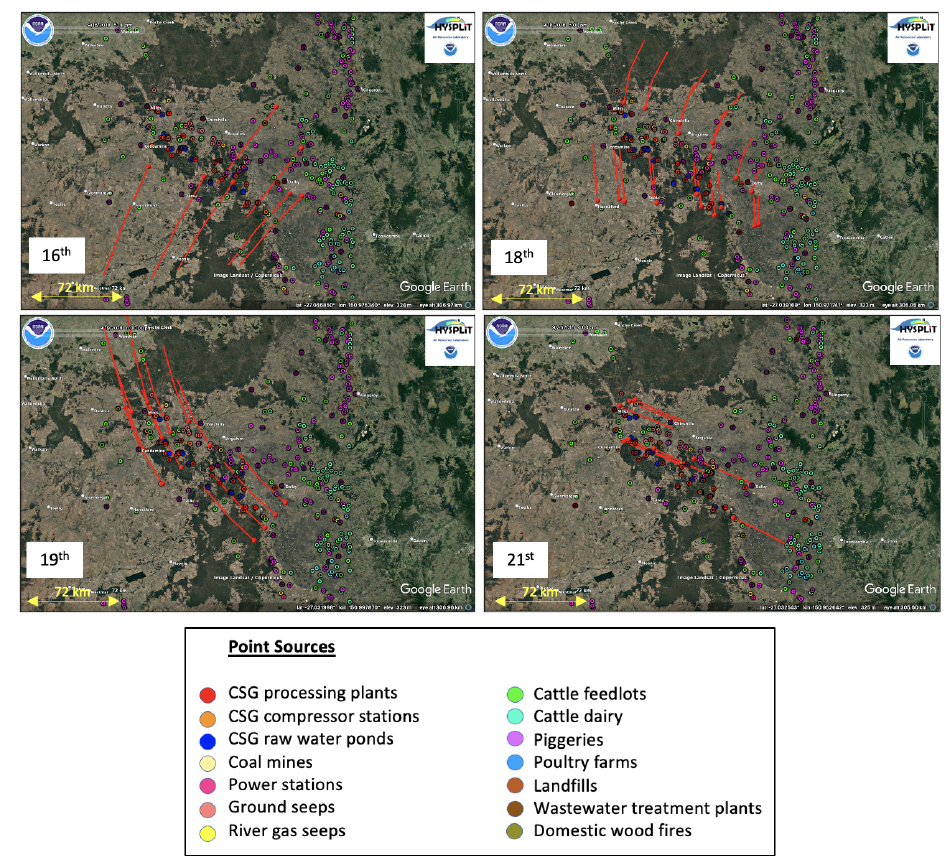
Figure A1. Two-hour HYSPLIT back-trajectory path lines (red) for each day of IFAA sampling. The back trajectory starts at the mid-point of the air sample collection interval (circled end of the red line) (image © Google Earth).